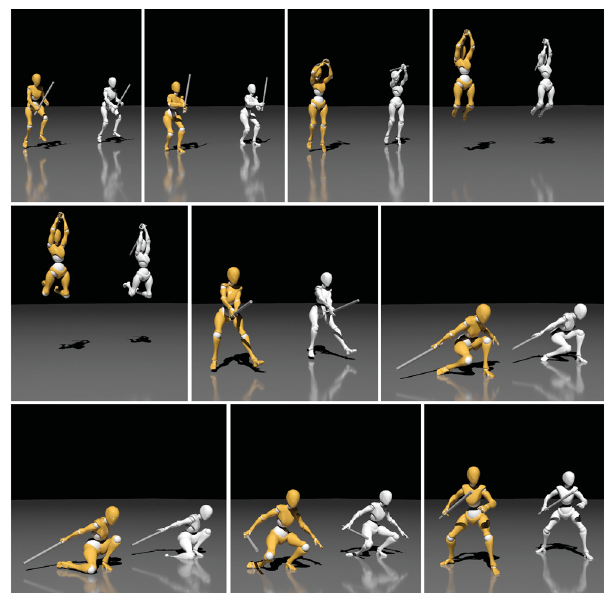
Fig. 1 Frames from an animation, before (character on right in grey) and after (character on left in yellow) editing using our